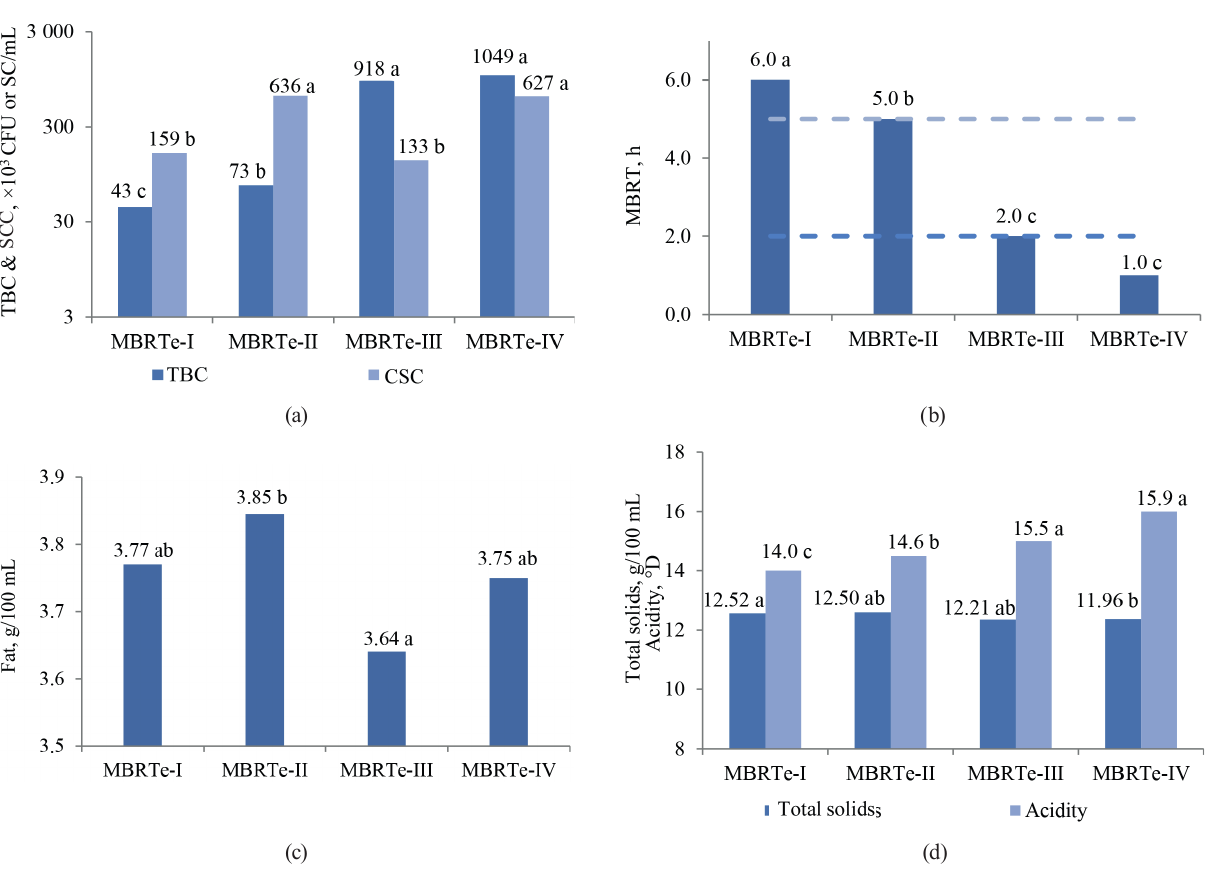
(TBC) and (b) log (TBC) vs MBRT. The dashed red lines represent the values 10 10